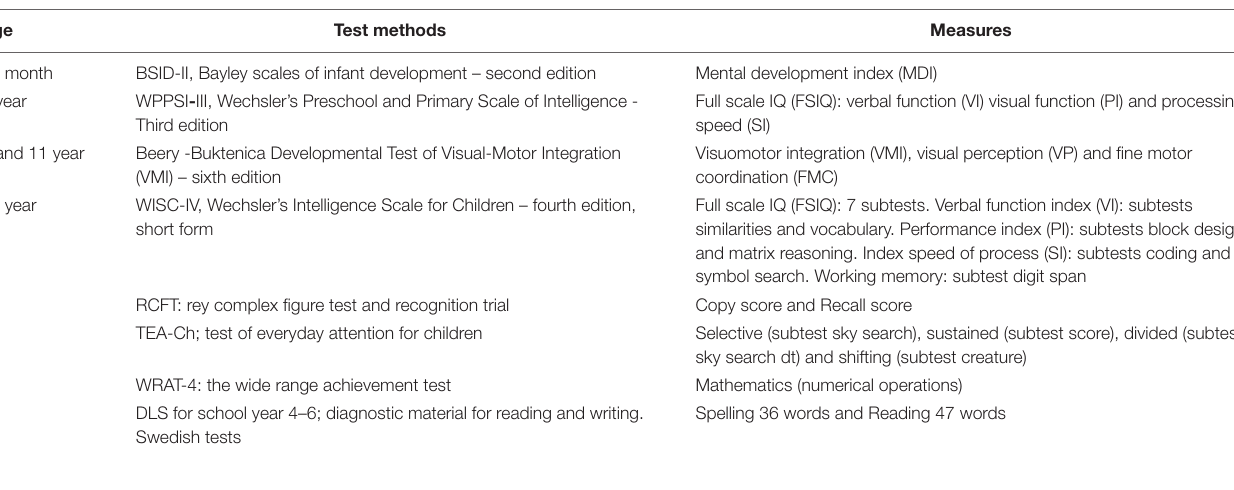
TABLE 2 | Cognitive test during follow up.